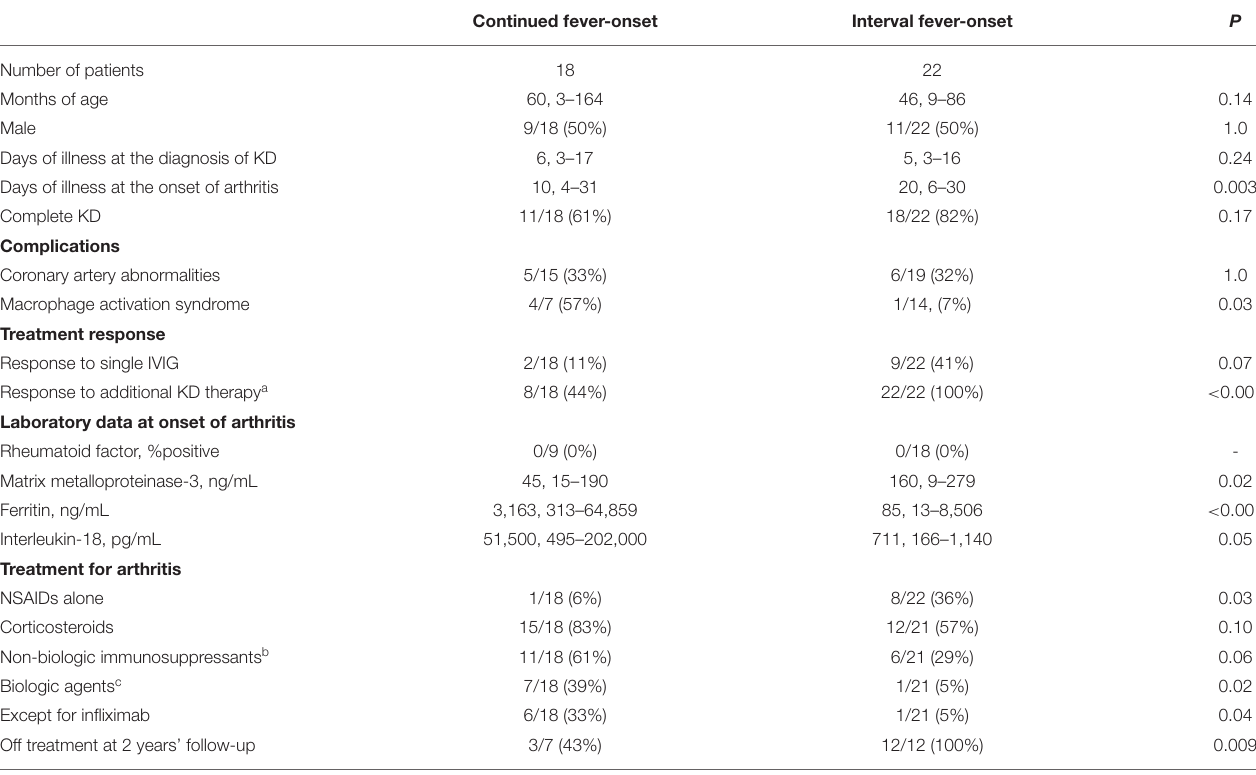
TABLE 4 | Clinical characteristics of registered patients with KD and arthritis that required